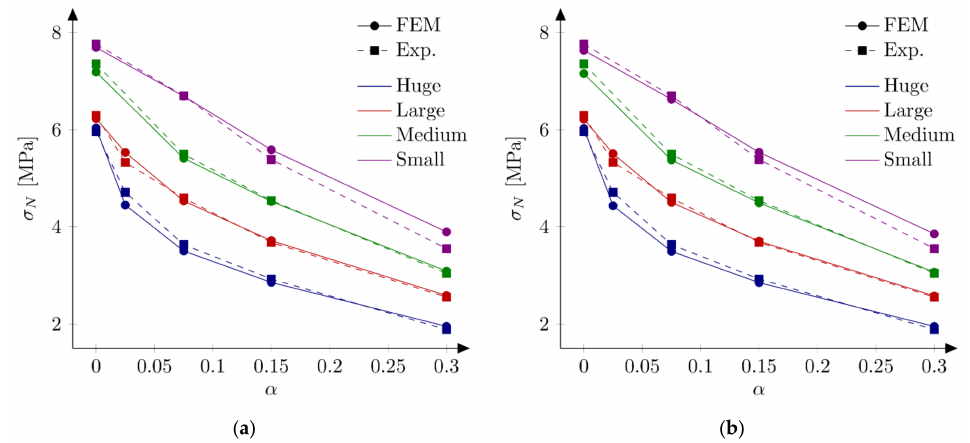
Figure 14. Nominal and experimental strengths with rational Bezier softening law and: ( a ) set S13: f t = 5.2 MPa, G f = 35 N/m, w = 4; ( b ) set S14: f t = 5.2 MPa, G f = 35 N/m, w = 4, b = 1 cm, β 0 =